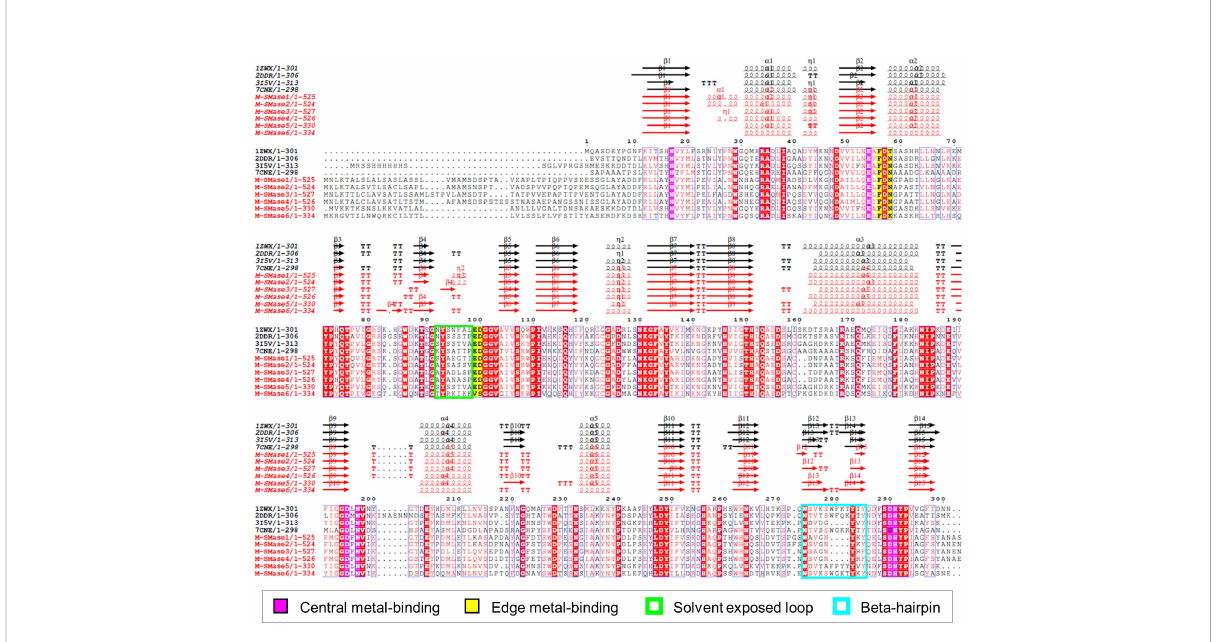
PDB database are depicted in Supplementary Figure S3. Identical residues are boxed in red. Metagenomic SMases are labeled with a red color. Note that 3I5V is not a naturally occurring protein sequence but is a His-tagged version at the